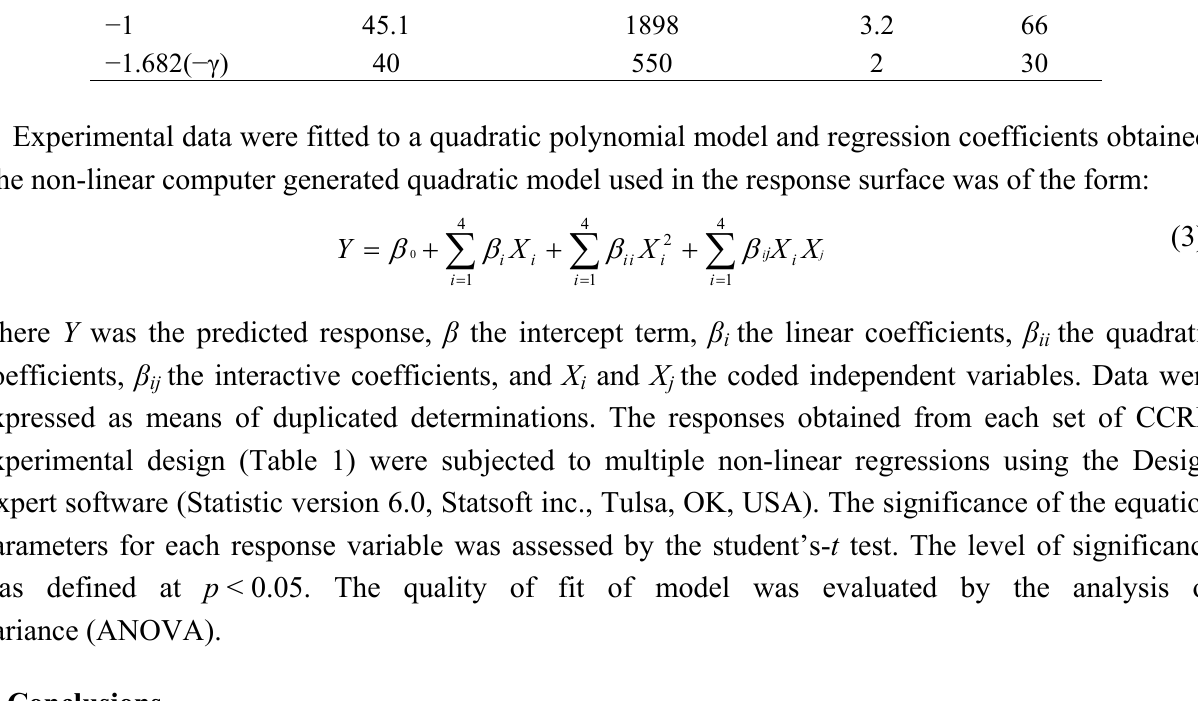
), enzyme-to-substrate 1 ), reaction time (min) 3